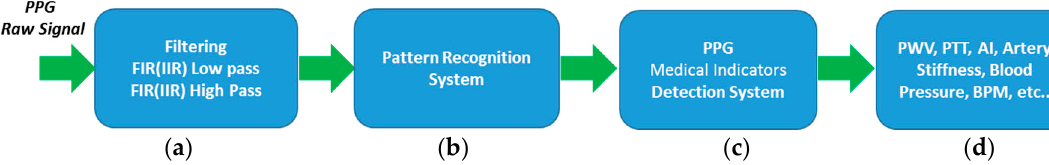
Figure 5. PPG Pattern Recognition Pipeline. PPG raw signal filter ( a ), the PPG pattern recognition system ( b ), medical indicators detection system ( c ) and indicators extraction stage ( d ). Table 1. PPG filtering: FIR filter configuration